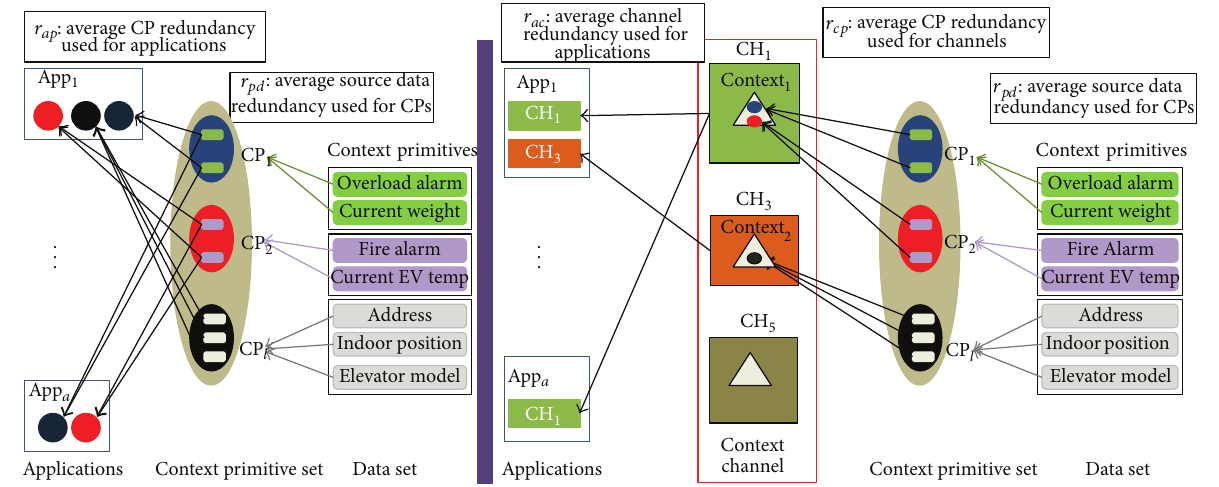
Figure 4: Context distribution with/without context